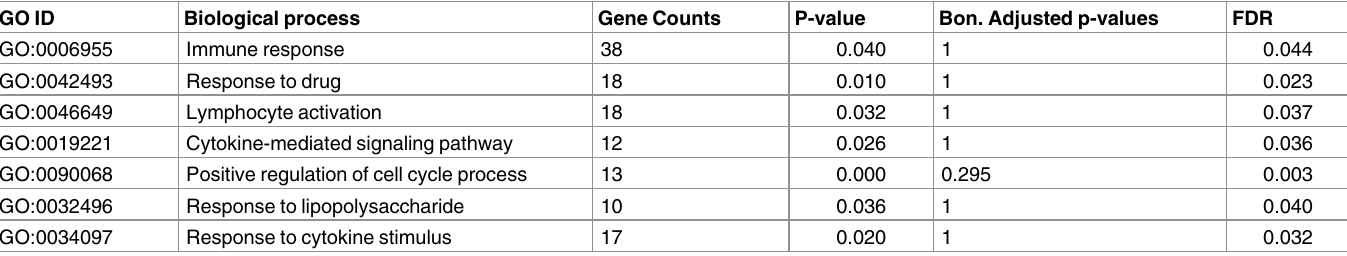
Table 4. Biological process GOs of Duroc cluster 32 post PRRSV